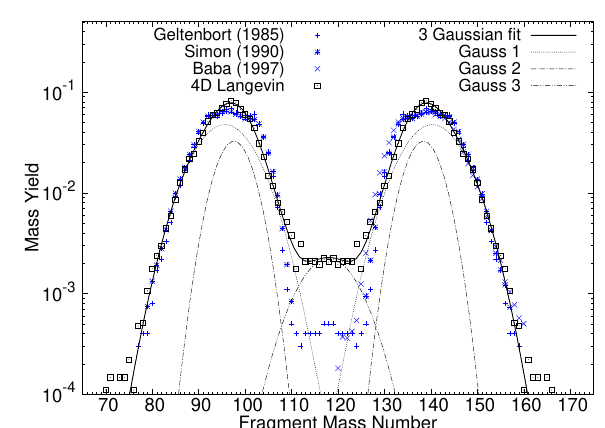
Figure 2. The fitted total kinetic energy as a function of fis- sion fragment mass TKE ( A ) taken from Ref. [7] compared with (cid:31) (cid:30) experimental data. The open squares are Langevin calculated TKE ( A ) and solid line is the fitting (cid:31) (cid:30)